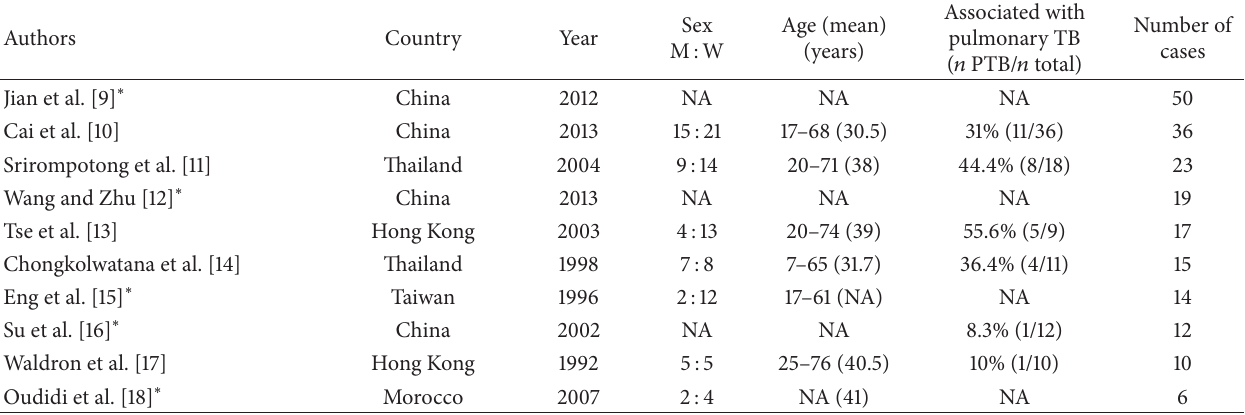
Table 1: Summary of large series NPTB